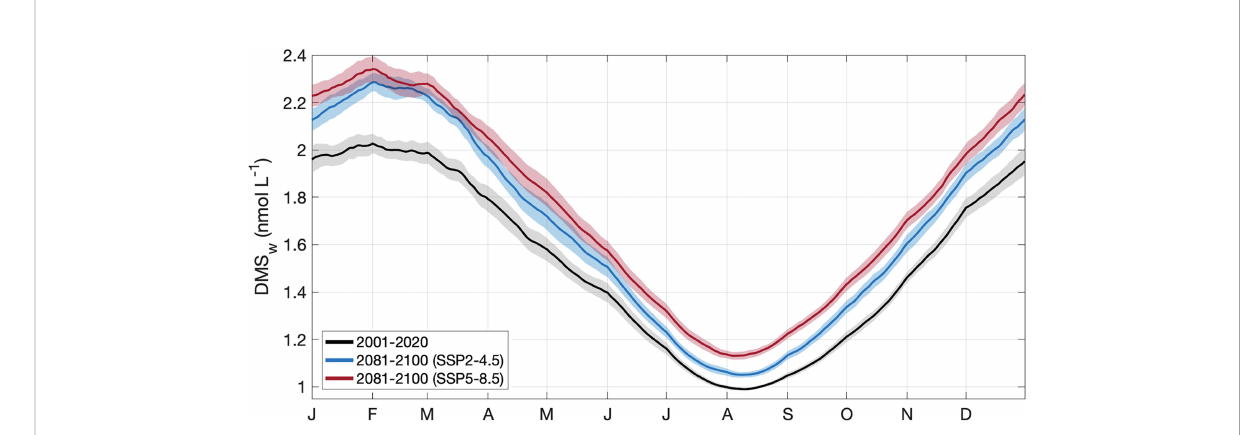
FIGURE 4 Area-averaged climatology ± 2 SE (shaded area) of DMS w in the GBRMP, derived from CMIP6 contemporary (black) and end of century model output for SSP2-4.5 (blue) and SSP5-8.5 (red)